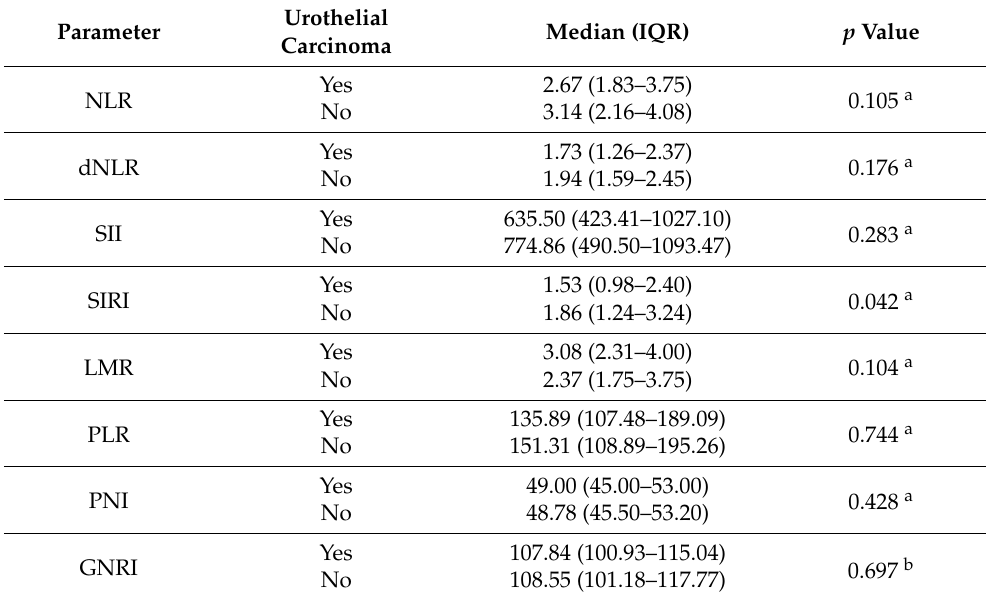
Table 5. Associations of inflammatory and nutritional parameters with the histological type of bladder